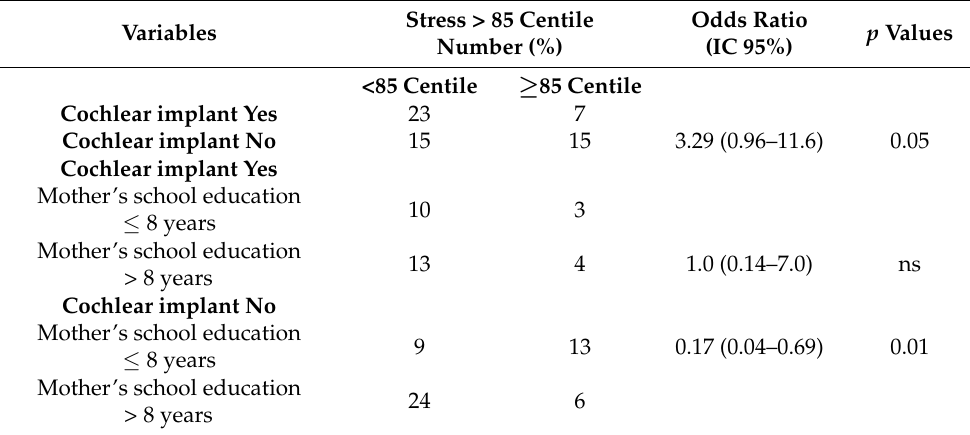
Table 3. Overall stress adjusted for potentially confounding variables. Stress > 85 Variables